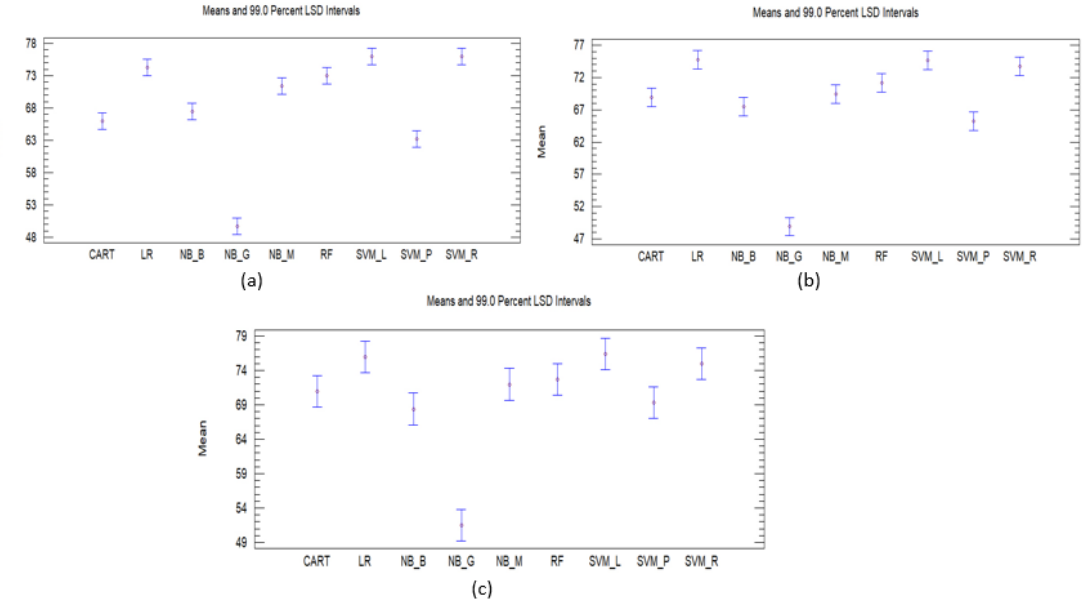
Figure 5. Box plot showing LSD results on Kabita’s Kitchen dataset using ( a ) tf-idf, ( b ) count and ( c ) term frequency